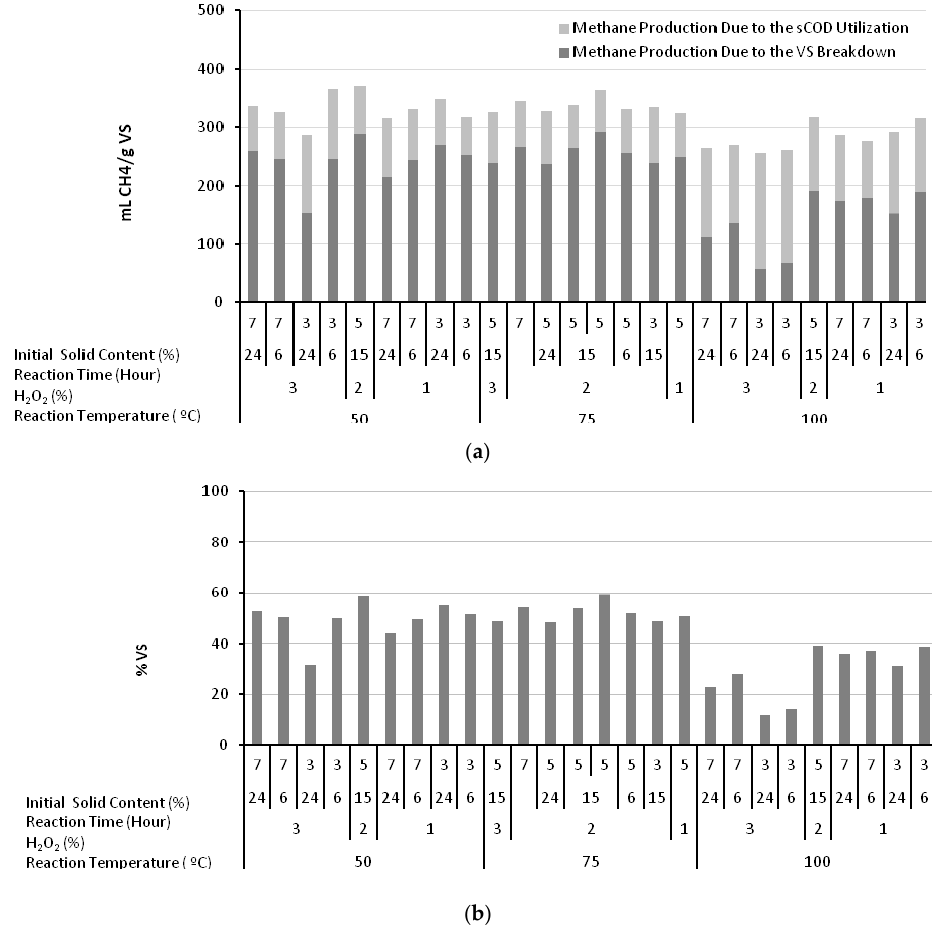
Figure 3. Methane production from sCOD and volatile solid (VS) destruction ( a ) and VS breakdown ( b ) due to the impact of alkaline H 2 O 2 treatment.